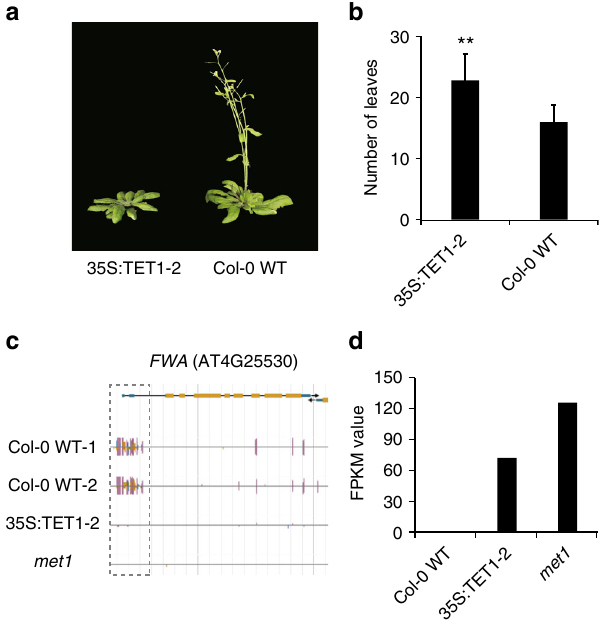
Fig. 3 35S:TET1 plants have a delayed fl owering phenotype. a Photographs of one 35S:TET1-2 transgenic plant and Col-0 WT plant and b corresponding number of rosette leaves. Error bars indicate s.d. (** t -test, p value <0.01). c Genome browser view of FWA (AT4G25530). Both CG and non-CG DNA methylation are depleted from the 5 ′ UTR in 35S:TET1-2 plants (purple vertical lines = CG methylation, blue vertical lines = CHG methylation, and gold vertical lines = CHH methylation). d Expression level (FPKM) of